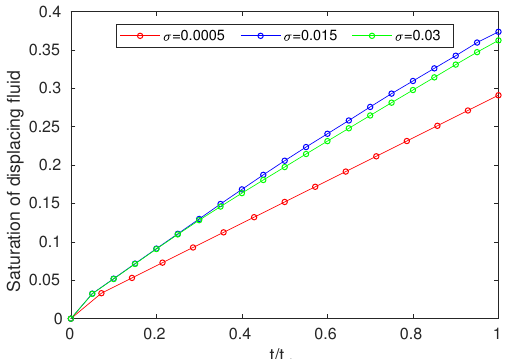
Figure 8. Evolution of the displacing fluid saturation for the interfacial tension of 0.0005 mu · ts − 2 , 0.015 mu · ts − 2 and 0.03 mu · ts − 2 .